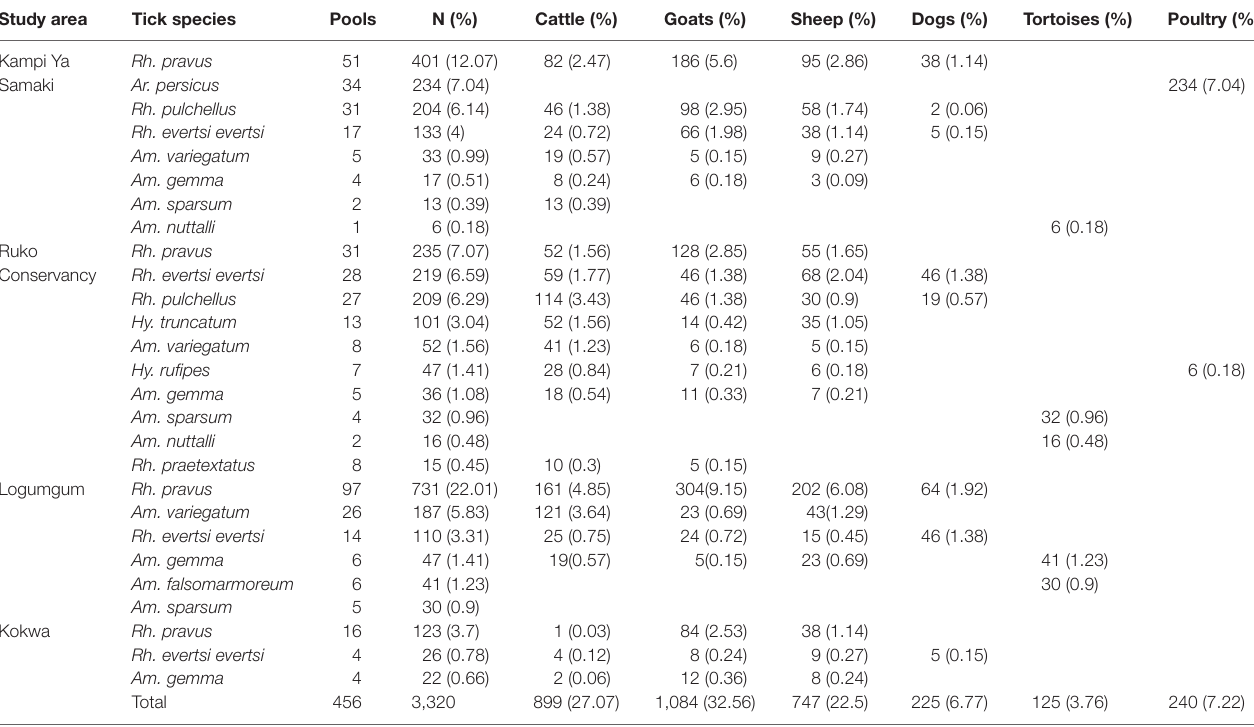
TaBle 2 | Ticks sampled from different host species in four study areas of Baringo county. study area Tick species Pools n (%) cattle (%) goats (%) sheep (%) Dogs (%) Tortoises (%) Poultry (%)